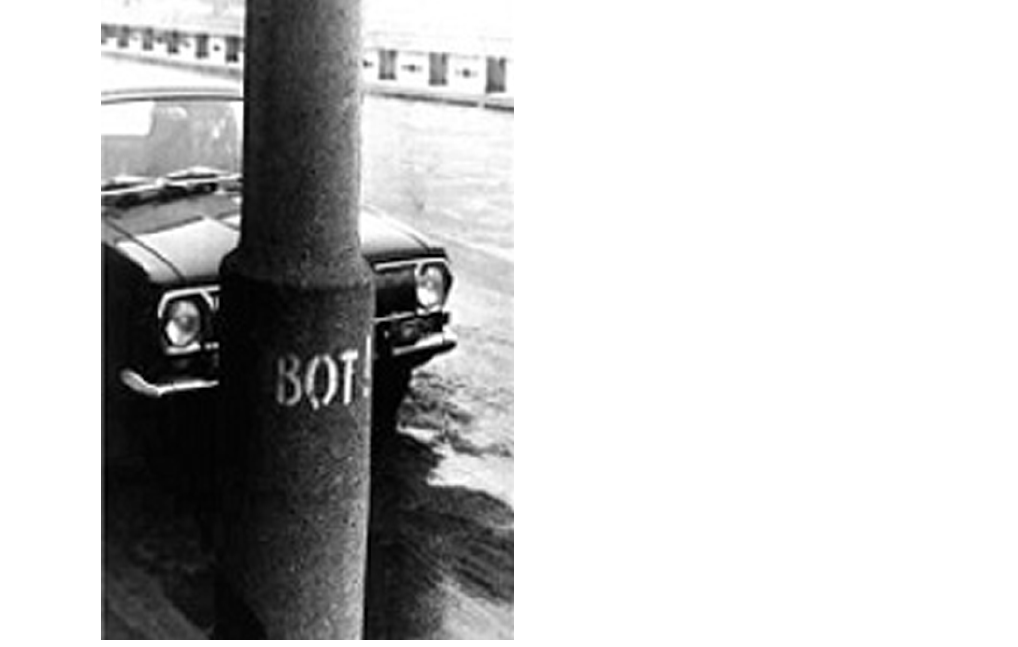
Figure 28. SZ. Here! From the Inscriptions ( Nadpisi ) series, 1980. Black-and-white photograph. 18.2 cm × 11.8 cm. Courtesy of the artists.